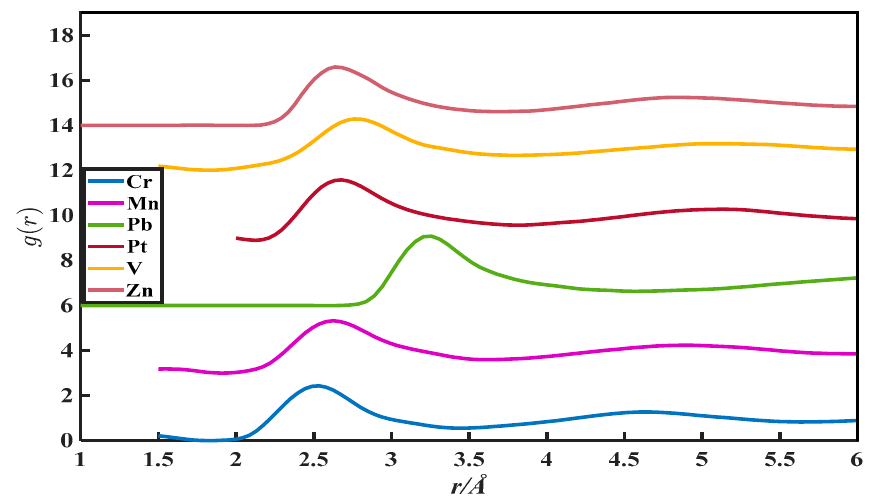
Figure 5. The pair distribution function of Cr, Mn, Pb, Pt, V, and Zn.